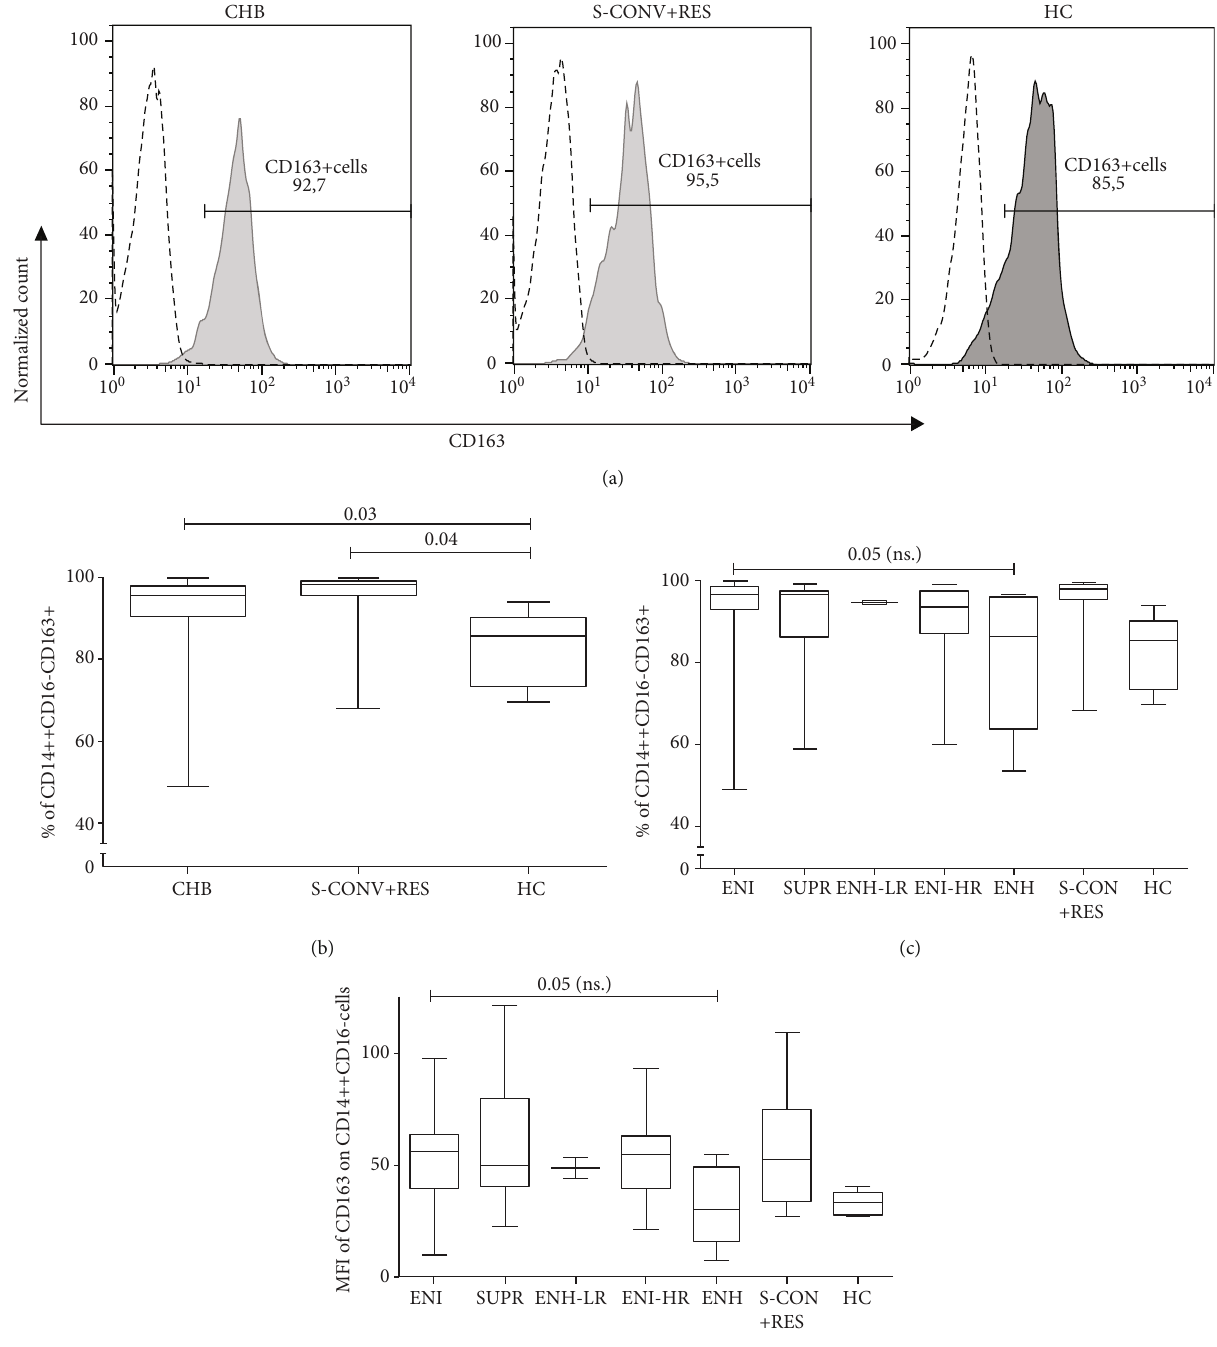
Figure 3: Frequency and expression of CD163 within intermediate monocytes. (a) Representative histograms showing CD163 expression in CHB, S-CONV+RES, and HC groups (solid lines), with adequate FMO controls (dashed lines). (b) CD163 expression on intermediate monocytes in CHB, S-CONV+RES, and HC groups. (c, d) Comparative analysis of CD163 expression on intermediate monocytes with reference to the phase of CHB infection. Data presented as median values with 25 th and 75 th percentile and minimum-maximum p = 0 : 0592 , p = 0 : 057 , p = 0 : 063 , respectively). No signi fi cant correlations were found between viral factors (HBV-VL, qHBsAg) and monocyte CD163 expression, plasma sCD163, or plasma sTWEAK.